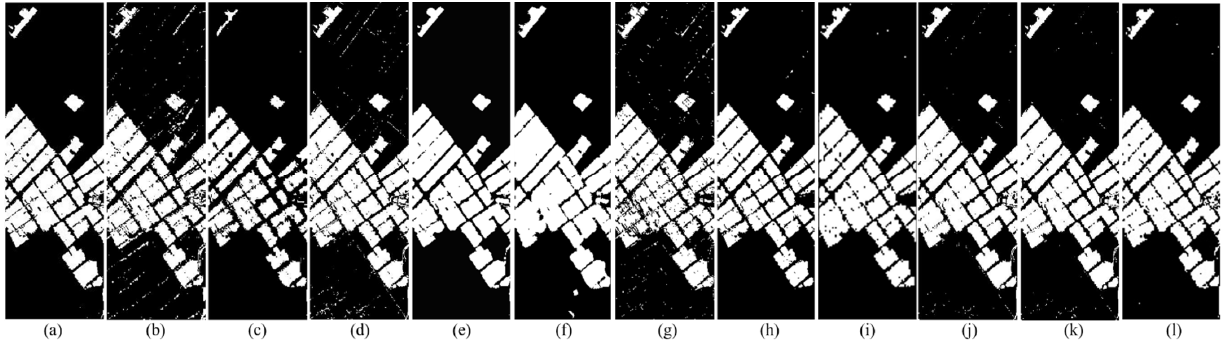
Figure 6. Binary detection results in the Yancheng dataset: ( a ) ground truth, ( b ) LSCD, ( c ) ASCD, ( d ) HOSVD, I TDRD, ( f ) PCANet, ( g ) DSFANet, ( h ) HI-DRL, ( i ) SSTN, ( j ) UTT-SVD, ( k ) UTT-noSVD, and ( l ) STT.